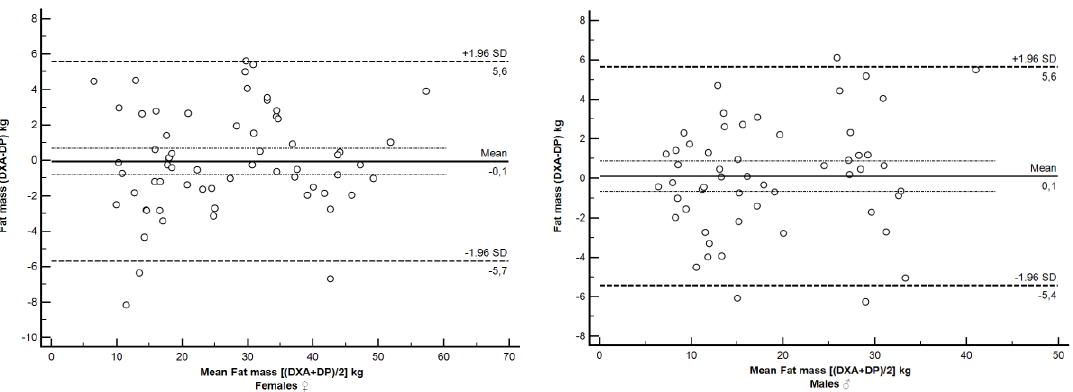
Figure 3. The Bland–Altman plots to illustrate the differences between individual dual X-ray absorptiometry (DXA)-measured and digital image photography (DP)-predicted fat mass (FM) as a function of the mean values of females ( left ) and males ( right ). Linear regression line describes the bias with 95% confidence intervals (1.96 SD)